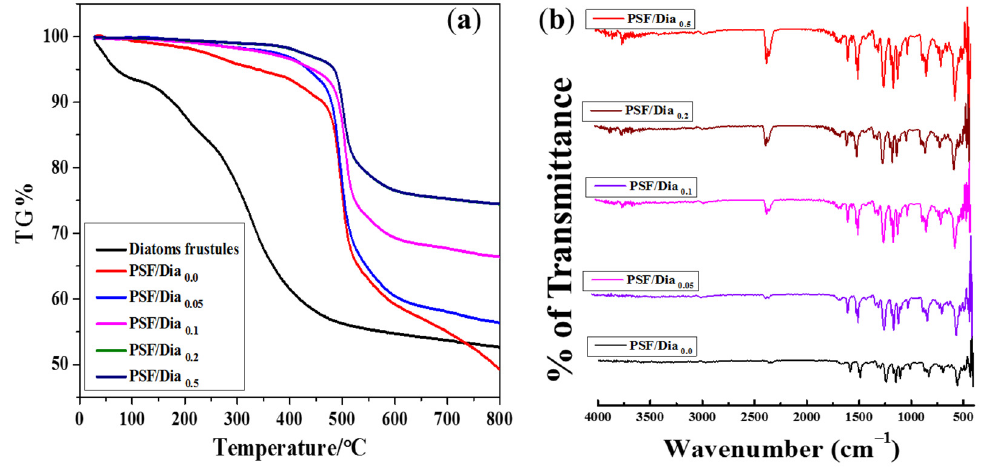
Figure 4. Physical characteristics of membranes. ( a ) Thermal stability and ( b ) ATR-FTIR spectra of control and diatomite-embedded PSF composite membranes.